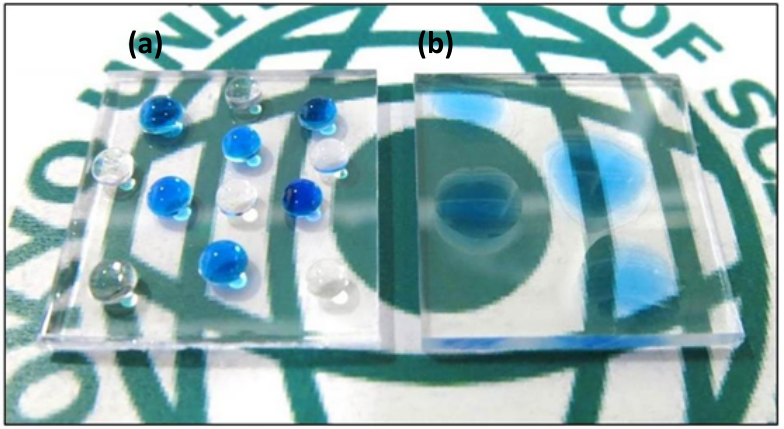
Figure 6. Optical photograph of water drops on bare PC substrate ( a ) and coating prepared from 7 vol% of SiO in TiO after 30 min. UV irradiation ( b ). 2 2